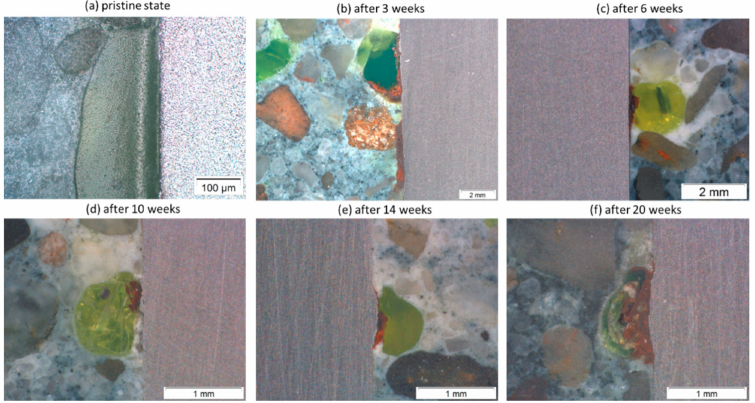
Figure 13. Observation of corrosion products at the pores positioned at the interface between mortar and carbon steel 1.8977 surface before ( a ) and after ( b ) 3, ( c ) 6, ( d ) 10, ( e ) 14, and ( f ) 20 weeks of